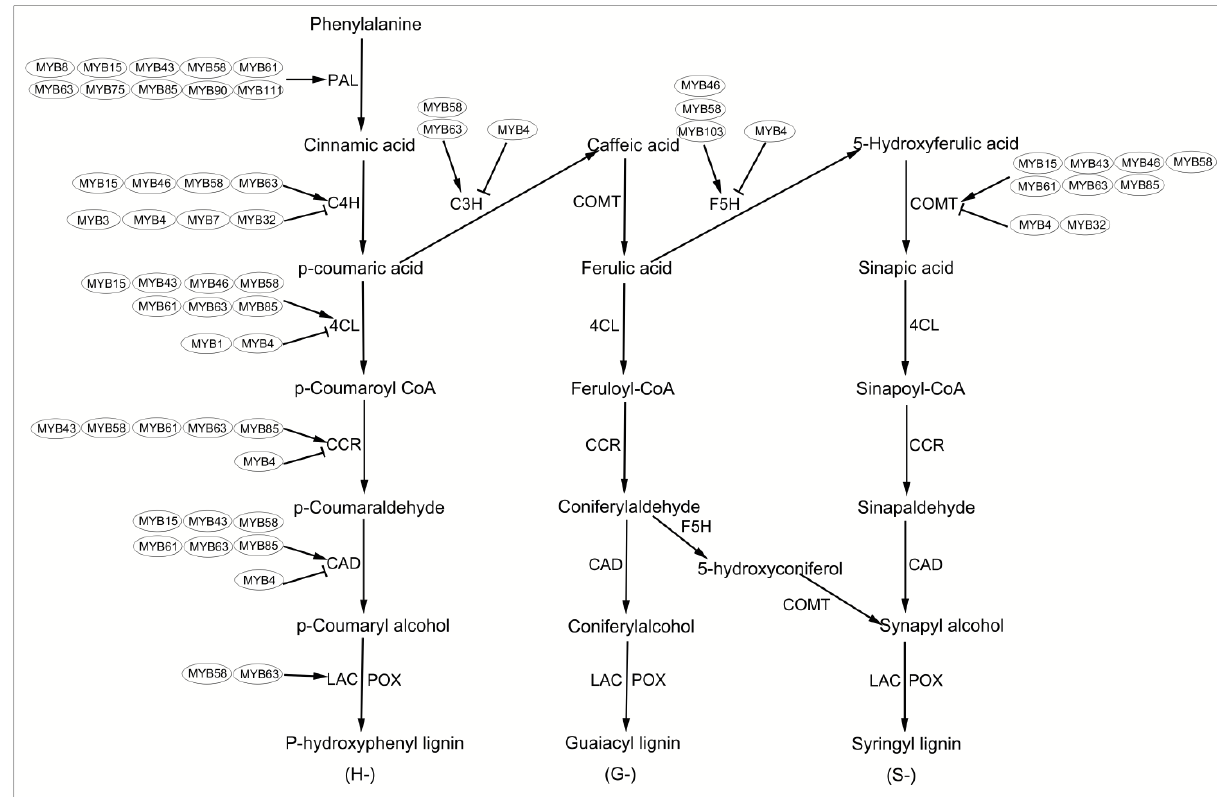
Figure 2. Phenylpropane lignin biosynthesis pathway in Arabidopsis . In this model, MYB transcription factors control the expression of genes in the lignin synthesis pathway. MYB58 and MYB63, MYB4 can activate/inhibit almost all the enzymes in the lignin synthesis pathway, respectively. All TFs appear to be in ovals in the figure. Solid arrows and flat-headed arrows represent positive and negative transcriptional regulation between transcription factors and enzymes, respectively. The other solid arrows represent the direction of the regulatory network. Note: PAL, phenylalanine ammonia lyase; 4CL, 4-coumarate-CoA ligase; C4H, cinnamate 4-hydroxylase; CCR, cinnamyl-CoA reductase; CAD, cinnamyl alcohol dehydrogenase; C3H, p-coumaric acid 3-hydroxylase; COMT, catechol-O-methyltransferase; F5H, ferulic acid 5-hydroxylase; POX, peroxidase; LAC, laccase.